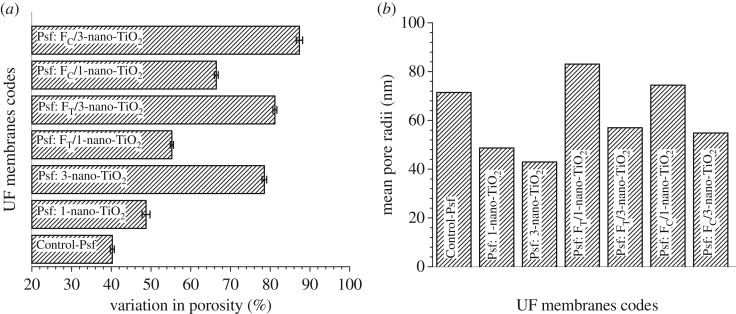
Variations in (a) porosities and (b) mean pore radii of membranes: Control-Psf UF, Psf: nano-TiO2 UF, Psf: FT-nano-TiO2 UF and Psf: FC-nano-TiO2 UF.